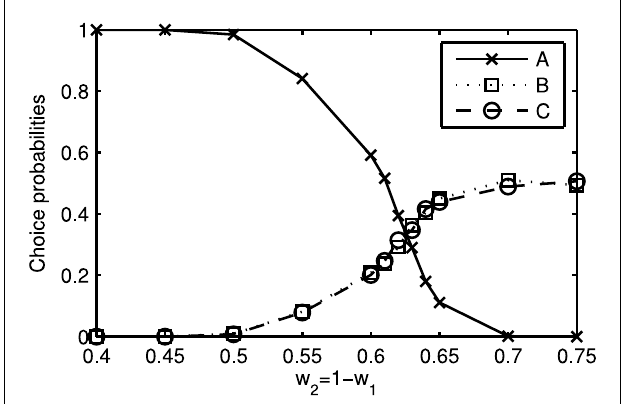
FIGURE 5 | Choice probabilities for choice between three alternatives A = (9, 1), B = (1, 9), and C = (1, 9) and different attention weights w 1 and w 2 for the two attributes. The abscissa is labeled with increasing values of w 2 corresponding to decreasing values of w 1 . For w 2 <0.625 a similarity effect can be observed.